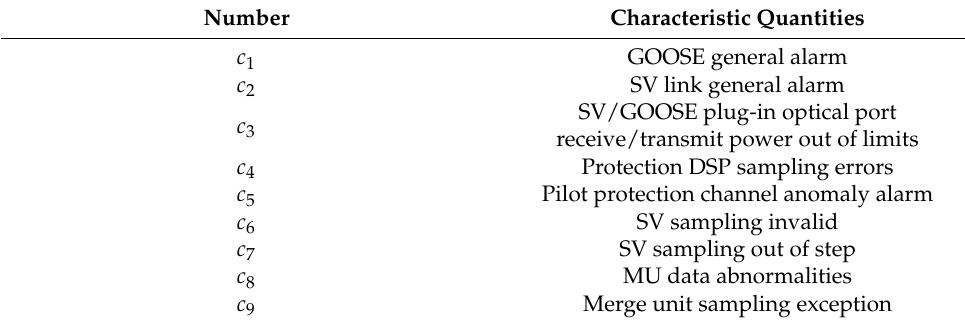
Table 2. Main characteristic quantities of protection system.